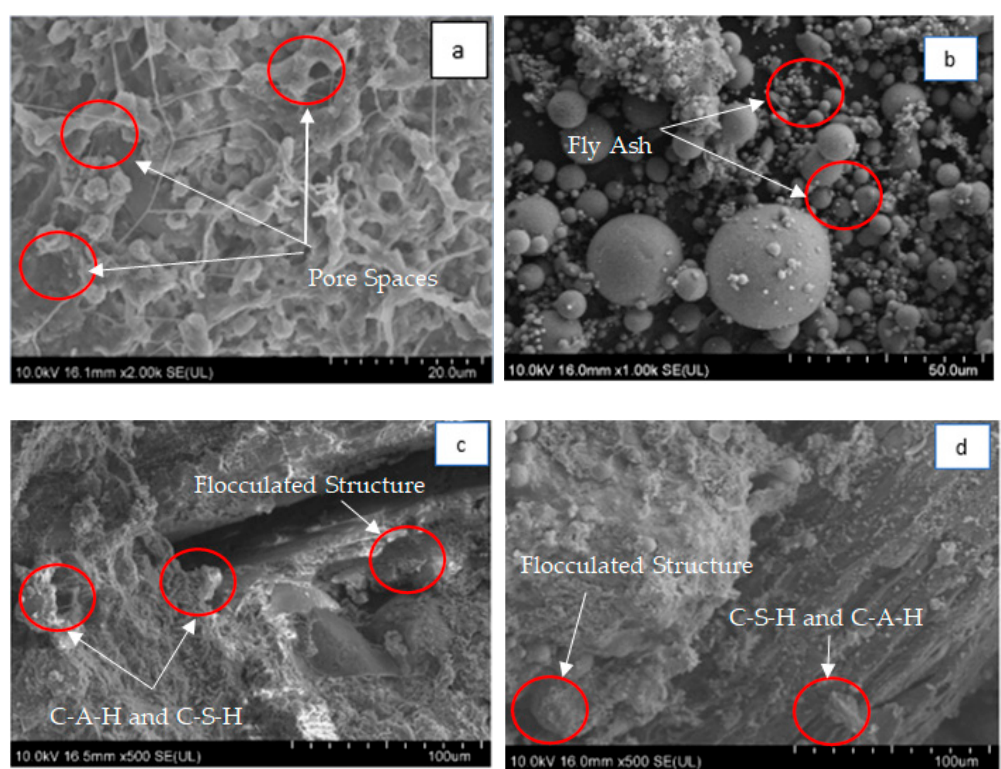
Figure 9. 90 day curing period of the FESEM micrographs for ( a ) untreated clay, ( b ) fly ash, ( c ) CLF90 5C, and ( d ) CFAF90 5C.